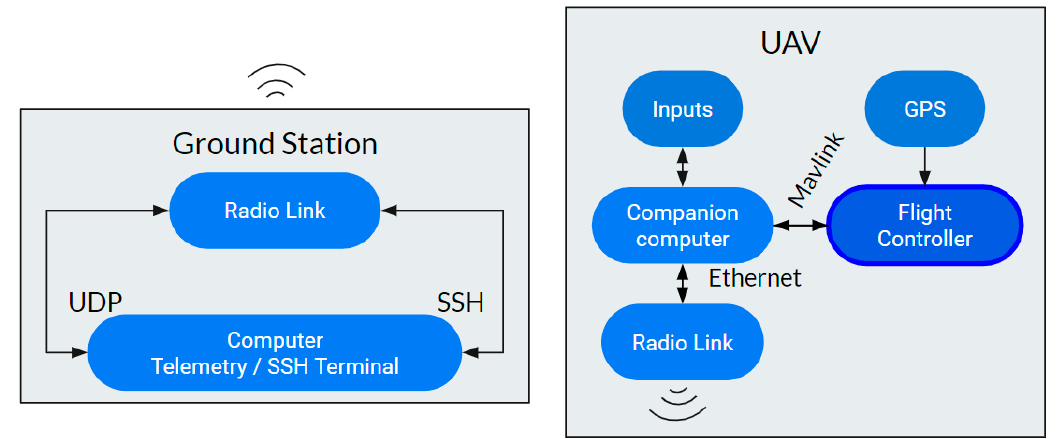
Figure 1. System configuration.